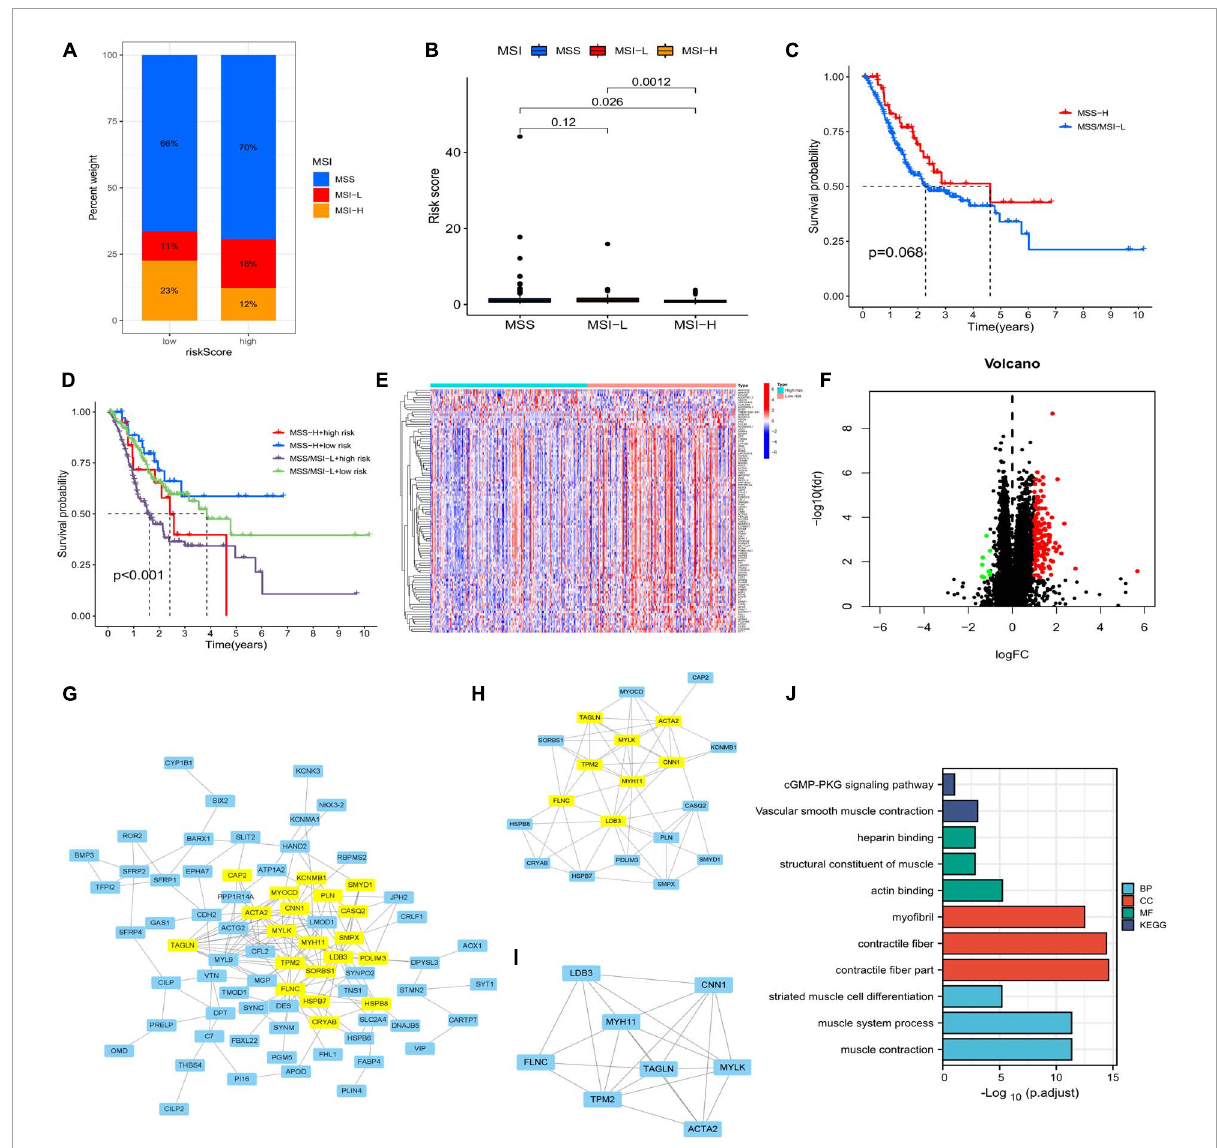
FIGURE8 (A,B) Relationship between MSI and risk score. (C) Correlation between survival time and MSS/MSI-L and MSI-H. (D) Survival analysis integrating MSI status and risk signature. (E) Differentially expressed genes (DEGs) between the two risk groups. (F) Volcano plot of DEGs. (G–I) Core DEGs in the two risk groups. (J) Gene ontology and Kyoto Encyclopedia of Genes and Genomes analyses of DEGs. MSI, microsatellite instability.